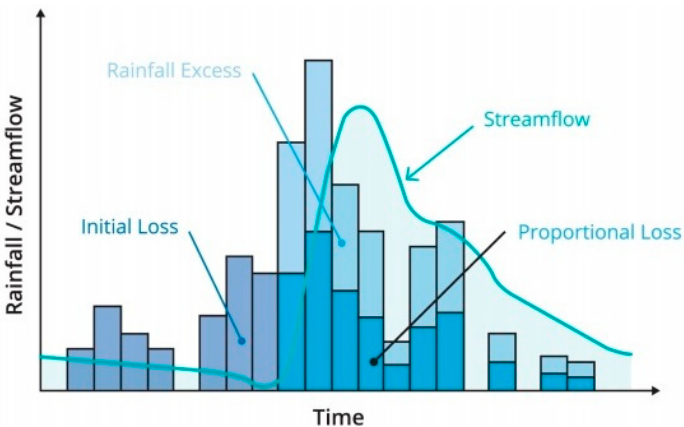
Figure 5. IL-PL Loss Models (Source: Section 3.2.3, ARR Book 5, Chapter 3). The flow depth in mm (𝑄 (cid:3033) ) was calculated by using Equation (2), where 𝑞 (cid:3033)((cid:3036)) is the filtered flow in m 3 /s for the 𝑖 (cid:3047)(cid:3035) time interval, ∆ t is the time step in seconds, and A is the catchment area in m 2 .